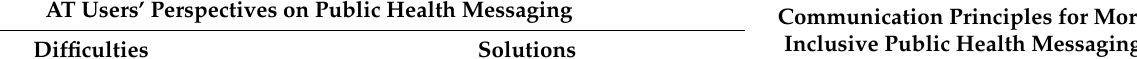
Table 2. Communication difficulties, solutions, and